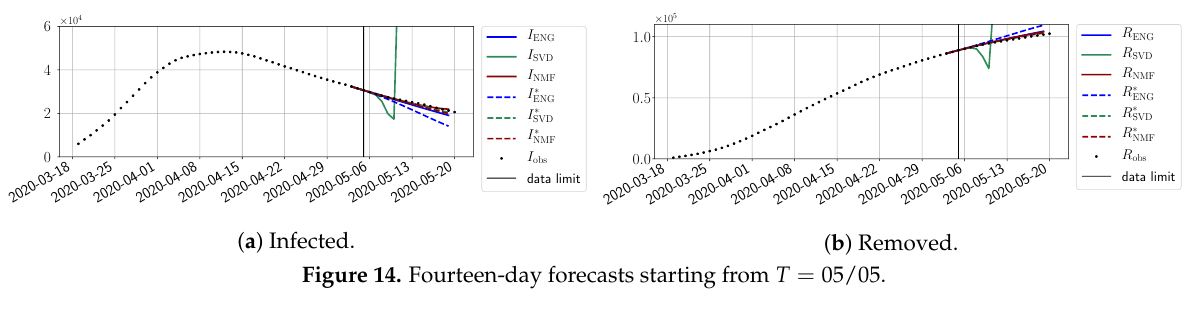
Figure 14. Fourteen-day forecasts starting from T =